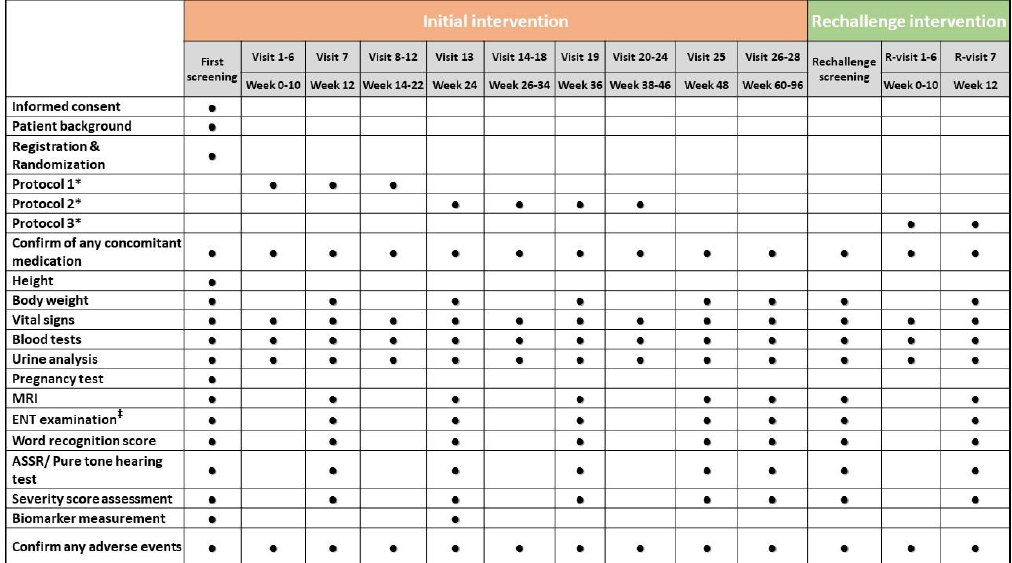
Figure 4. An outline of the study assessments and procedures scheduled. Each circle represents a task or test performed every two weeks. * Description of these protocols can be seen in Figures 2 and 3. ‡ ENT examination before the pure-tone test. ASSR, auditory steady-state response; ENT, ear, nose, and throat; MRI, magnetic resonance imaging.